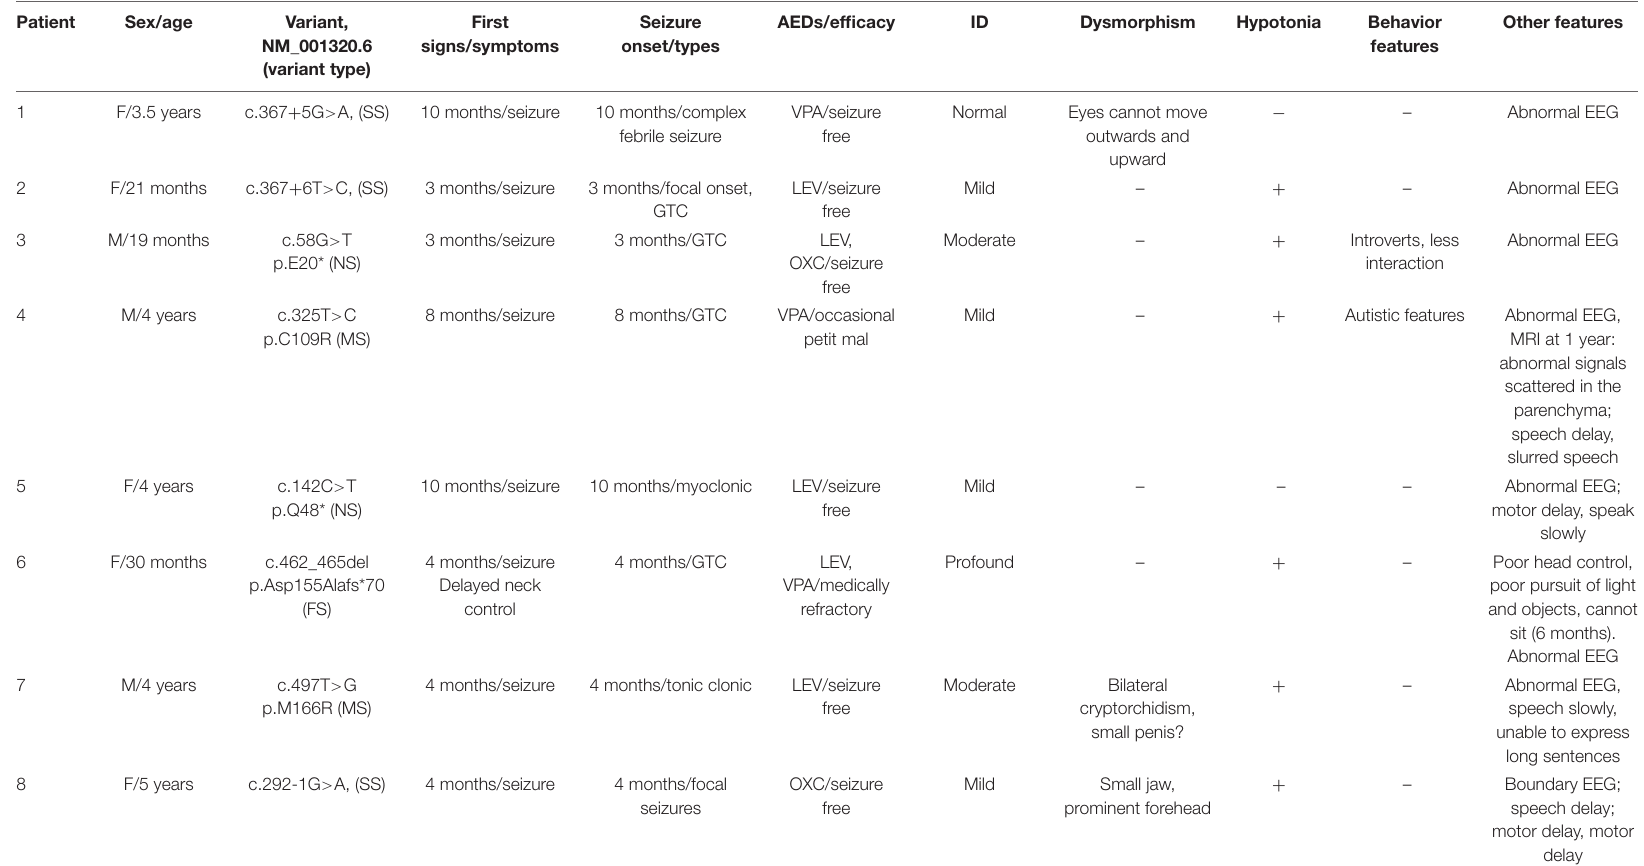
TABLE 1 | Genotype and phenotype details for individuals with CSNK2B variants. Patient Sex/age Variant,